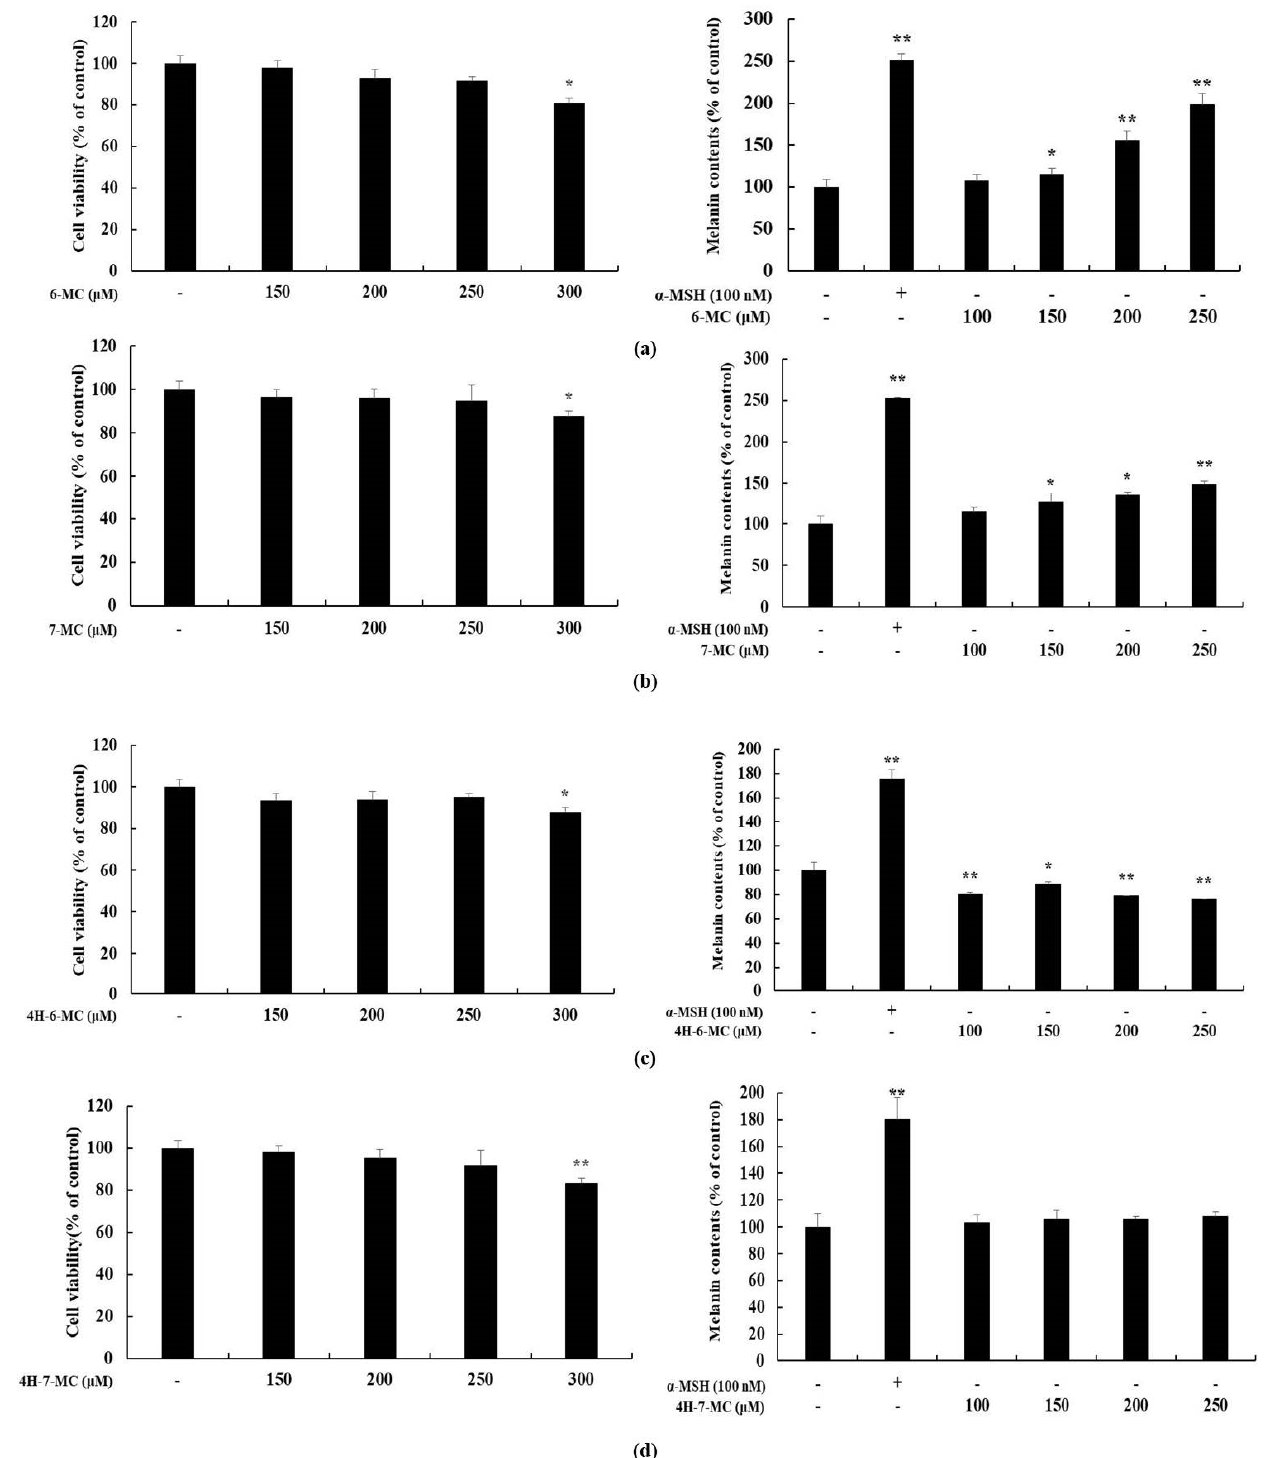
Figure 3. Effect of coumarin derivatives on proliferation and melanin contents in B16F10 cells. The cells were treated with various concentrations of coumarin derivatives for 72 h. α-MSH was used as the positive control. Proliferation and melanin contents of cells subjected to ( a ) 6-methylcoumarin (6-MC), ( b ) 7-methylcoumarin (7-MC), ( c ) 4-hydroxy-6-methylcoumarin (4H-6-MC), and ( d ) 4-hydroxy-7-methylcoumarin (4H-7-MC) treatment were expressed as percentages compared to the untreated control cells. The results are presented as the mean ± SD from three independent experiments. * p < 0.05, ** p < 0.01 versus untreated control cells.